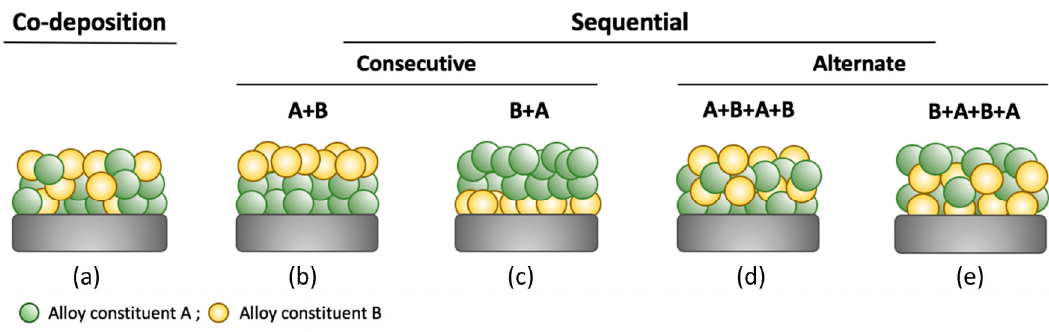
Figure 9. Different possibilities to prepare binary alloys by electroless plating: ( a ) co-deposition; ( b,c ) sequential deposition; ( d , e ) alternative deposition.